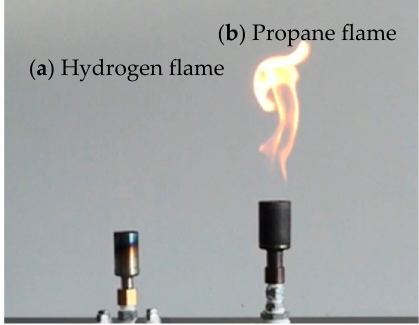
Figure 6. Flame images of hydrogen ( a ) and propane ( b ) taken by an ordinary CIS showing entirely invisible characteristics of the hydrogen flame.